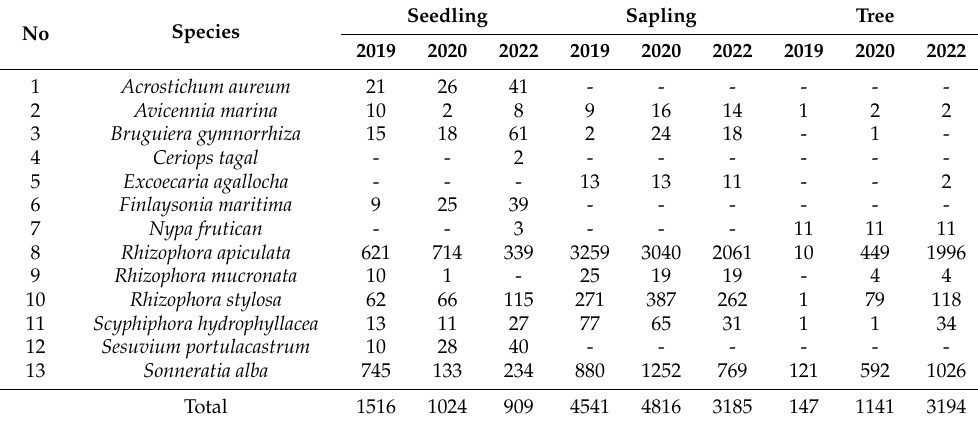
Table 6. Number of individuals observed in restored areas planted with seedlings using the census method from 2019–2022.